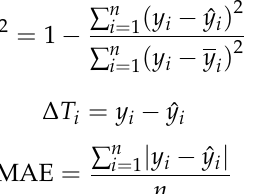
where T B 1 M ( t ) is the transient temperature of B1M, T C 1 M ( t ) is the transient temperature of C1M, and T s ( t ) is the transient feed temperature. The position of B2M is similar to B1M, and the position of A2M is similar to C1M. Thus, the transient temperature of B2M is predicted using the experimental data of A2M and the coefficients of Equation (5) to validate the C1M-B1M model, as follows: